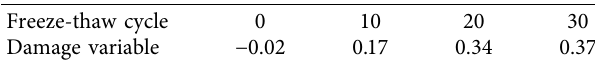
Figure 8: Relation curve between uniaxial compressive strength and freeze-thaw Table 2: Damage variable value when axial pressure is 5MPa.